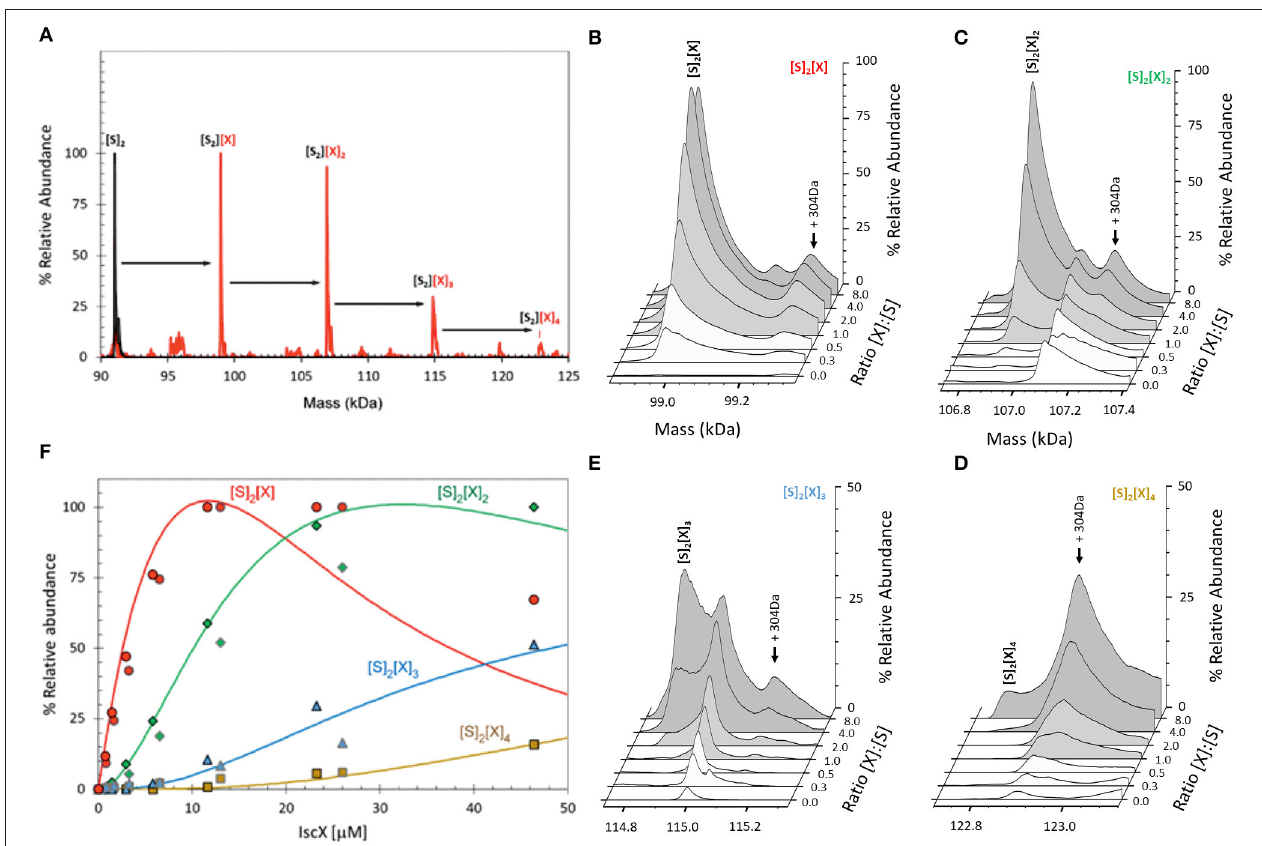
FIGURE 3 | ESI-MS investigation of complex formation between IscS and IscX. (A) Deconvoluted mass spectrum of IscS over the mass range 90–125 kDa, showing the presence of the IscS dimer (black spectrum). Addition of IscX at an 8:1 excess gave rise to a series of IscX-IscS complexes in which the IscS dimer is bound by 1–4 IscX protein molecules (red spectrum). (B–E) Deconvoluted mass spectra at increasing ratios of IscX to IscS showing the formation/decay of the four IscX-IscS complexes, as indicated. A + 340 Da adduct species is present in each of the spectra, including that of the IscS dimer, indicating that it originates from IscS. The precise nature of the adduct is unknown, but it is likely to arise from two β -mercaptoethanol hetero-disulfides per IscS (4 × 76 = 304 Da), as the protein is in a solution containing 20mM β -mercaptoethanol. (F) Plots of relative intensity of the four IscX-IscS complexes, as indicated, as a function of IscX concentration. Solid lines show fits of the data to a sequential binding model for 1–4 IscX per IscS dimer. IscS (3 µ M) was in 250mM ammonium acetate, pH 8. Note that abundances are reported relative to the most abundant species, which is arbitrarily set to 100%.